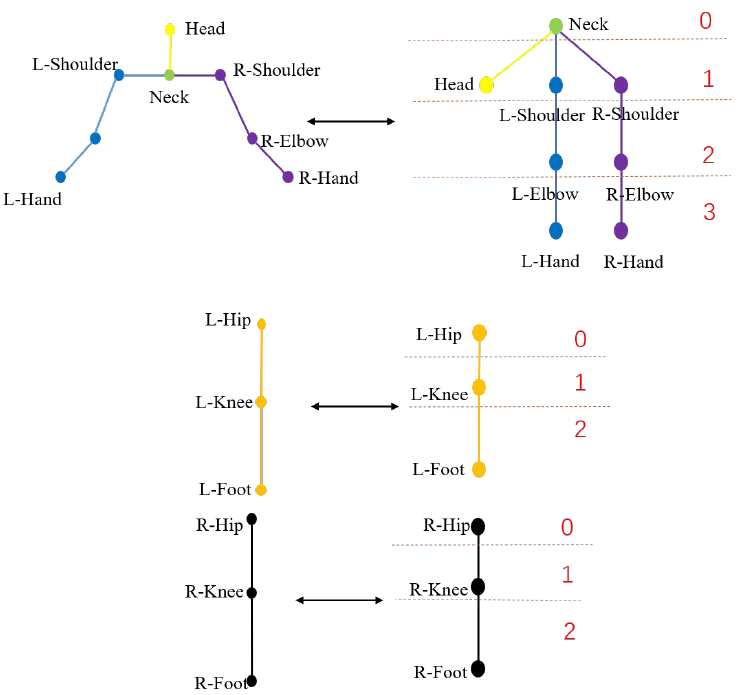
Figure 4. The subtrees and the corresponding local kinematic